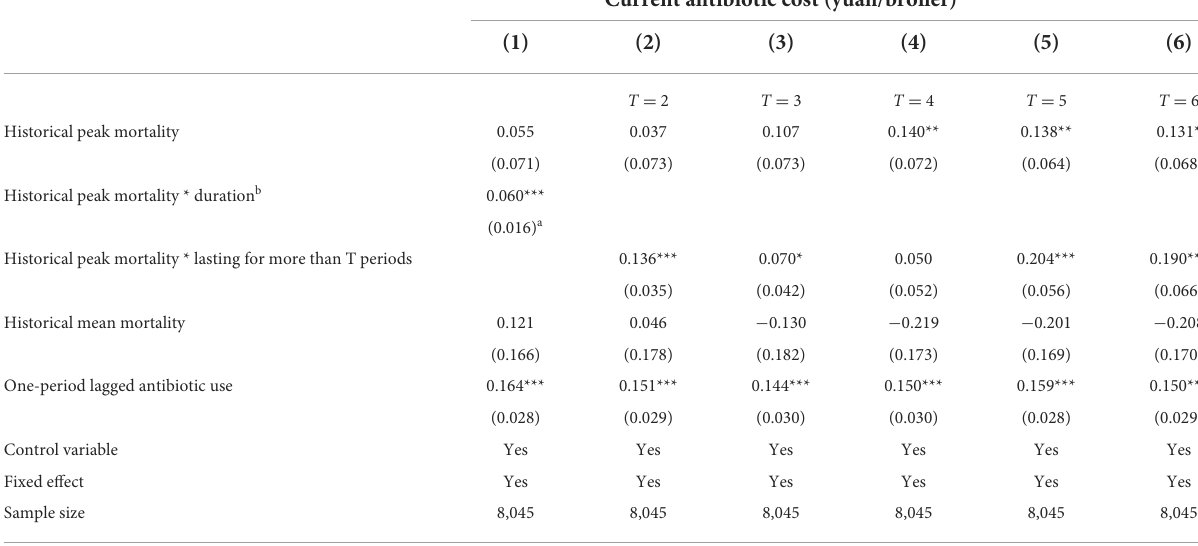
TABLE 4 Intertemporal changes in the impact of historical peak mortality on current antibiotic